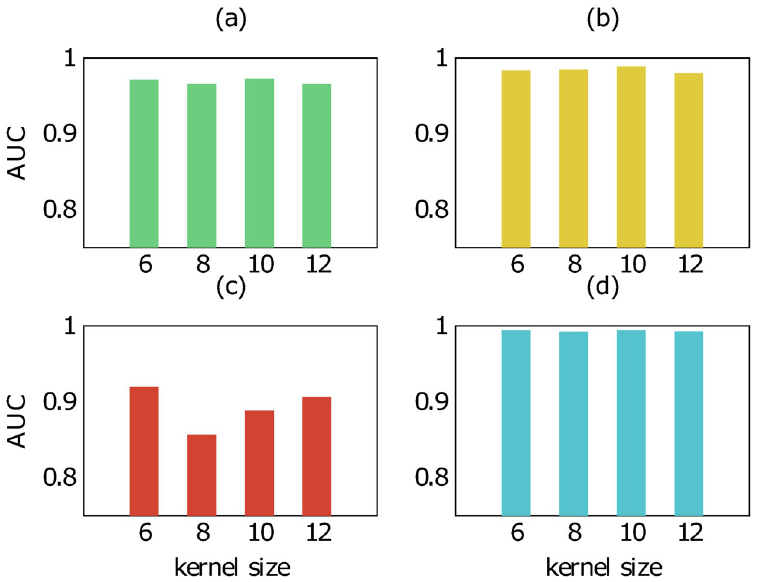
Fig 6. AUC score of our method trained with different kernel size on human data in four scenarios: (a) new compound-known protein, (b) known compound-new protein, (c) new compound-new protein, (d) known compound-known protein.